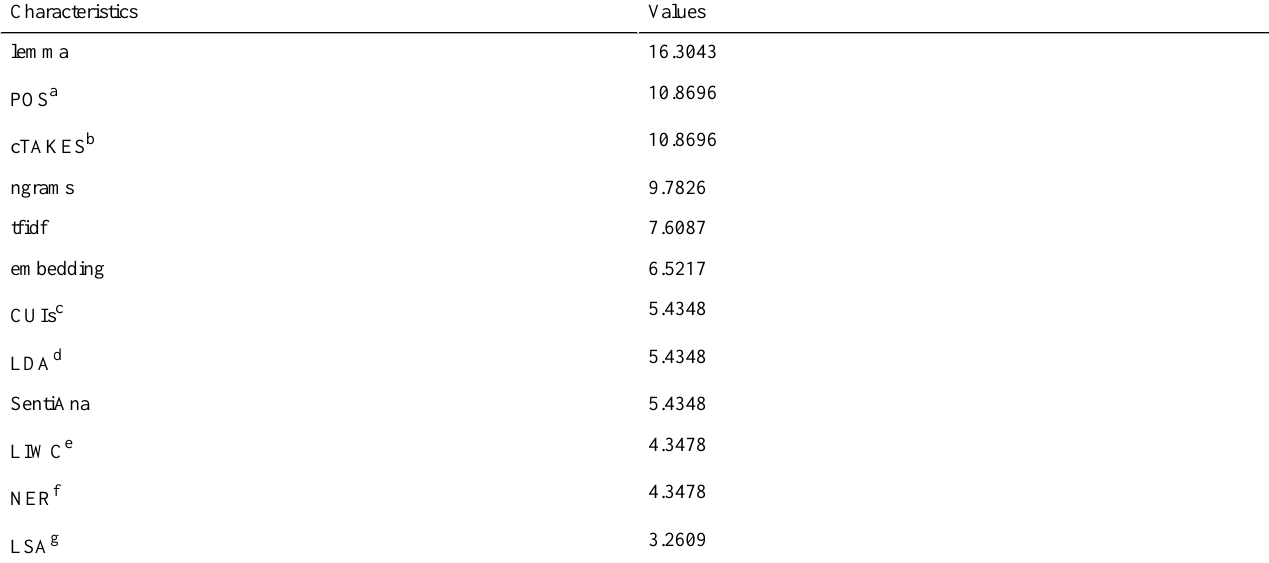
Table 2. Preprocessing